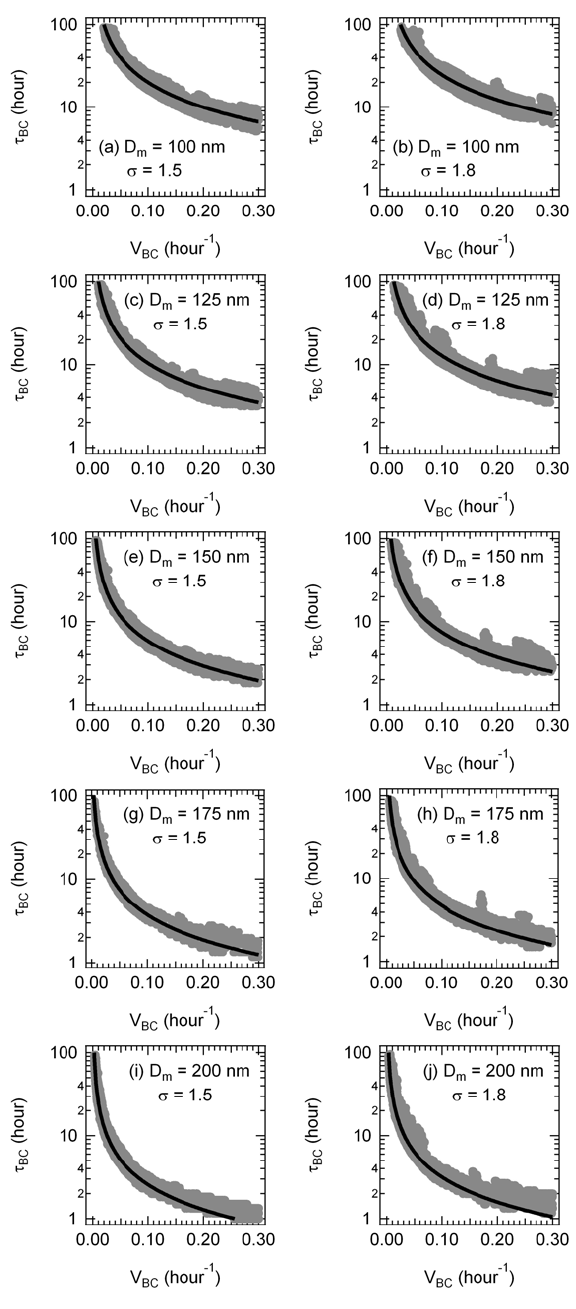
Fig. 2. Relationships between τ BC (e-folding time of the conversion from hydrophobic BC to hydrophilic BC) and V BC (hydrophobic- BC-mass-normalized coating rate, defined by Eq. 6) for all combi- nations of the initial parameters shown in Table 1 for each given lognormal BC size distribution shown in Fig. 1 (gray circles). The black curves show the fitted curve expressed by Eq.